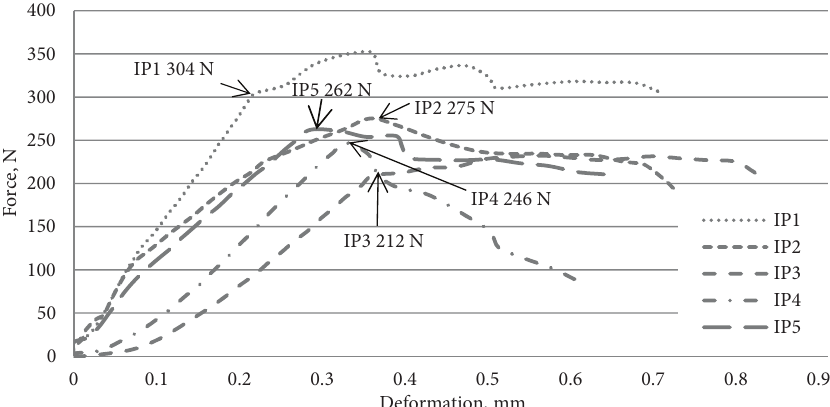
Figure 3. The strength test of industrial cattle manure compost granules IP1, IP2, IP3, IP4, IP5